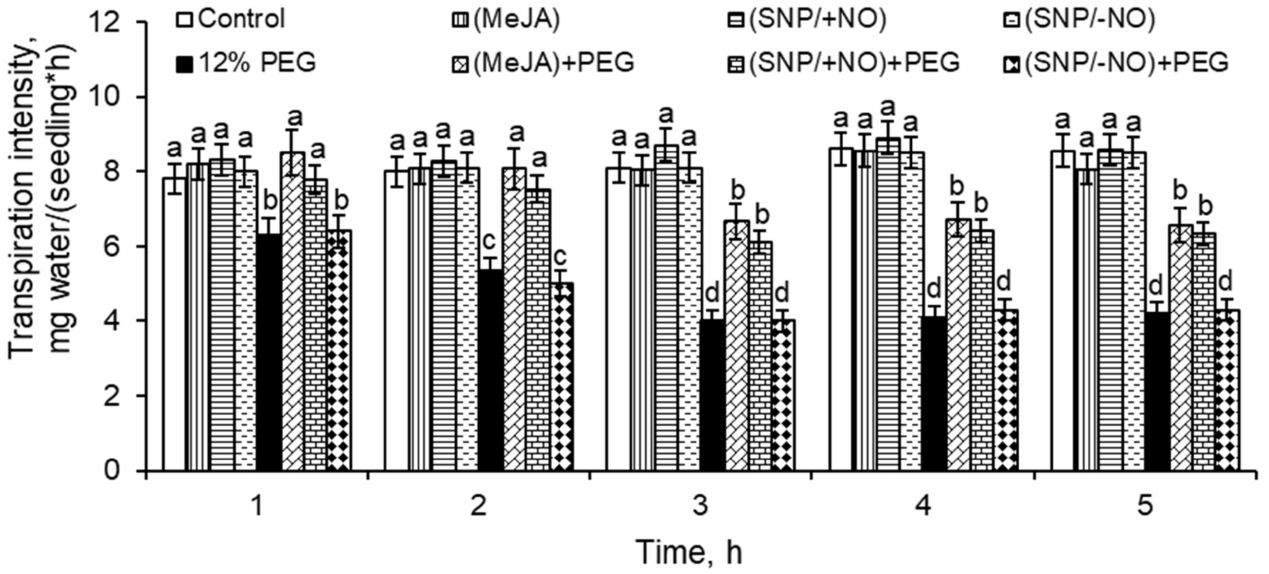
Figure 3. Effect of exogenous 10 − 7 M MeJA and 2 × 10 − 4 M SNP pretreatments on transpiration intensity of wheat leaves under water deficit, modulated by 12% PEG for 5 h. Data are the mean of three replicates; different letters show significant difference at p ≤ 0.05 and bars indicate ± SE (n =